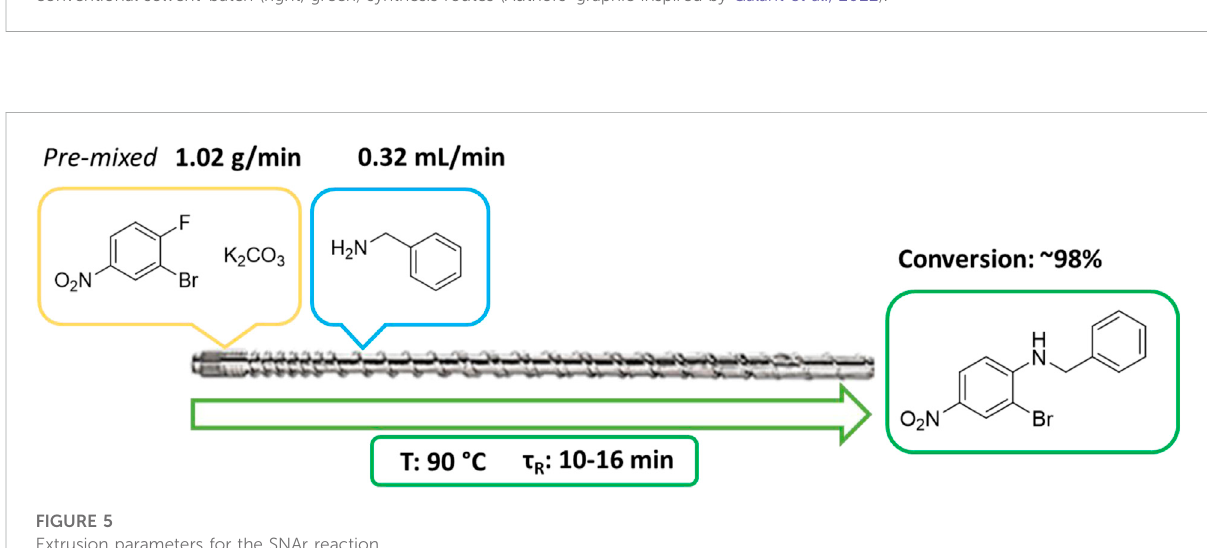
FIGURE 5 Extrusion parameters for the SNAr